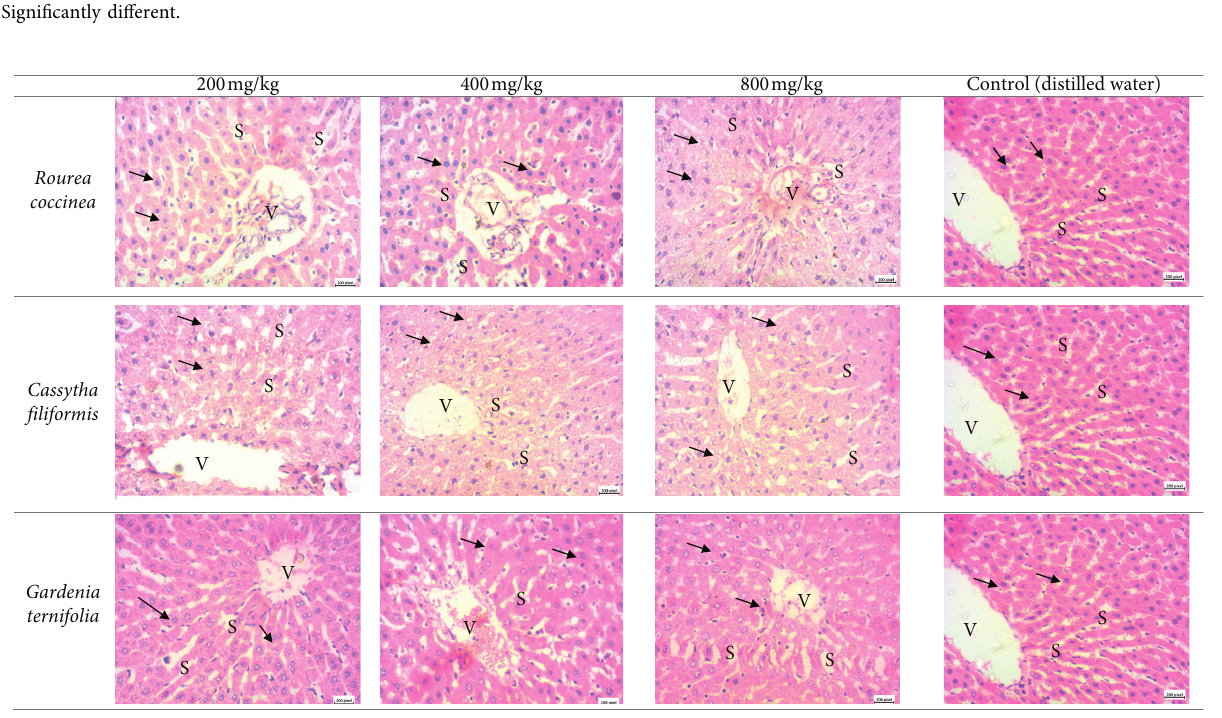
Figure 4: Liver histology of treated and untreated rats ( × 400